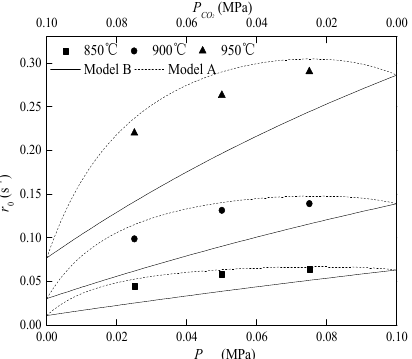
Figure 4. Comparison of experimental data and two conventional models.